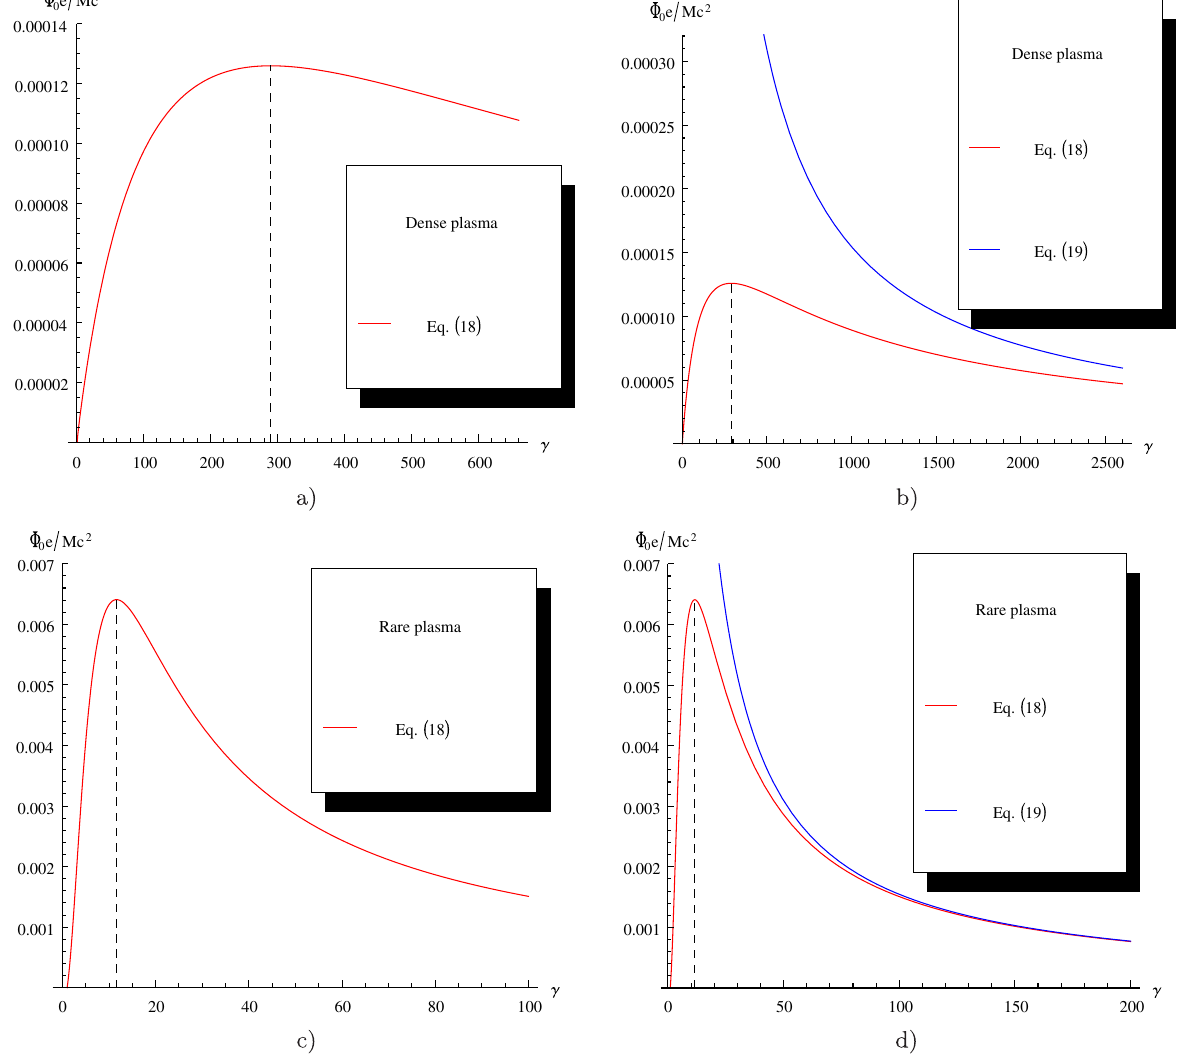
FIG. 2. (a) The relative stationary saturation amplitude of the plasma wake potential generated by the ultrarelativistic proton bunch Eq. (18) for (a), (b) dense (14) at n b ¼ 2 (cid:8) 10 12 cm (cid:1) 3 , n p ¼ 10 16 cm (cid:1) 3 , (cid:1) 0 ¼ 289 and (c), (d) rare (15) plasmas at n b ¼ 2 (cid:8) 10 12 cm (cid:1) 3 , n 6 (cid:8) 10 12 cm (cid:1) 3 , (cid:1) 11 : 6 . In (b) and (d) the relative stationary saturation amplitude in the ultrarelativistic limit p ¼ 0 ¼ (19) is presented for